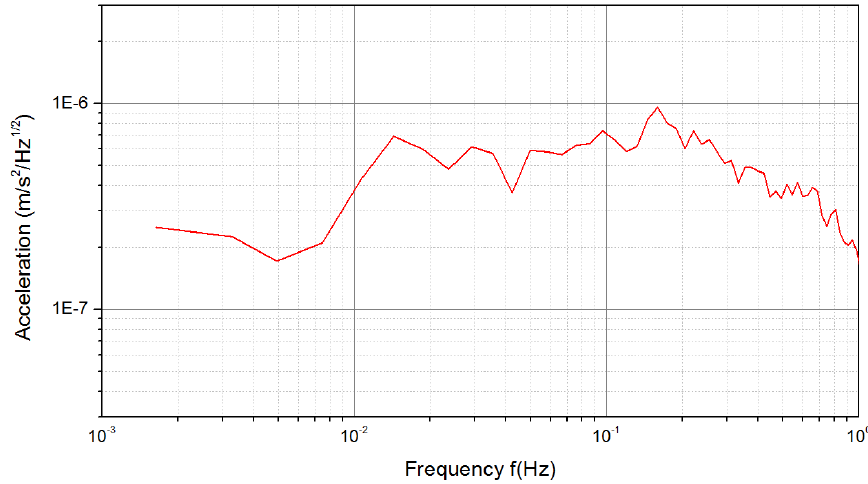
Figure 13. Acceleration resolution PSD of non-sensitive axis channel.